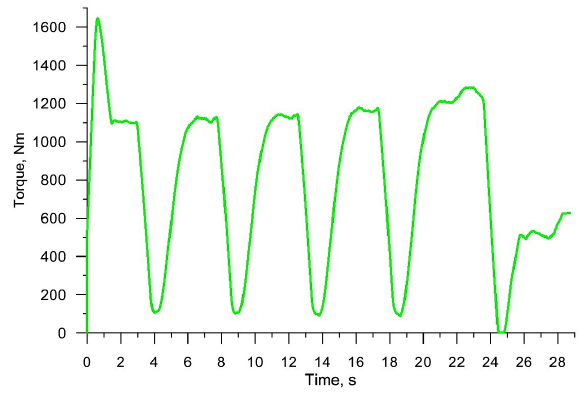
Figure 10: Variations in the torque on the roll in the skew rolling process for a crankshaft preform.